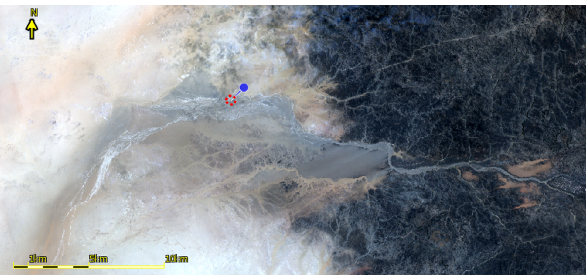
Figure A2. ©Copernicus data (2019). Sentinel-2 natural colour composite showing an alluvial deposit dust source west of the Tibesti mountains in Chad. The source emitted dust on 30 November 2015. The location of the pin is latitude 21.4001, longitude 15.8211. A 750m buffer is included in red. Background: European Space Agency Copernicus Sentinel-2 data 2018. Sentinel-2 data are provided under the terms and conditions prescribed by the European Commission’s Copernicus Programme. For detailed information on the data policy, appropriate usage, and citation of Sentinel data, please see: https://scihub.copernicus.eu/twiki/pub/SciHubWebPortal/TermsConditions/TC_ Sentinel_Data_31072014.pdf (last access: July